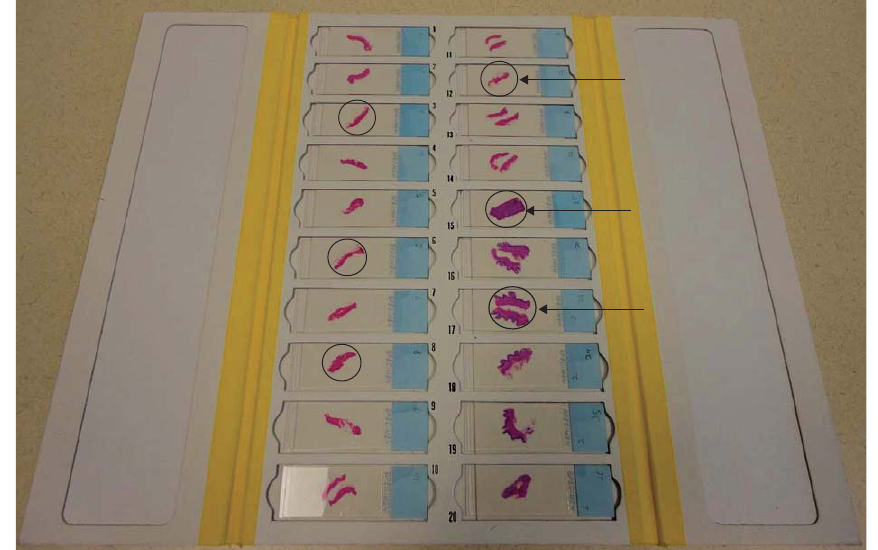
Fig. 3. Slide Tray and Stained Slides. A standard cardboard slide tray that a pathologist receives from the histology laboratory. It is open and contains twenty glass slides with tissue specimens (circles and arrows) that have been stained. In most instances, the slides of a single case number less than twenty and can thus be accommodated in one slide tray.